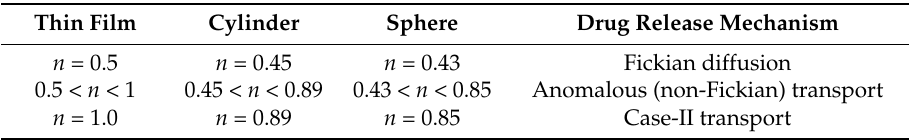
Table 4. Diffusional exponent n of the Ritger–Peppas equation and drug release mechanism from polymeric controlled delivery system for different geometries